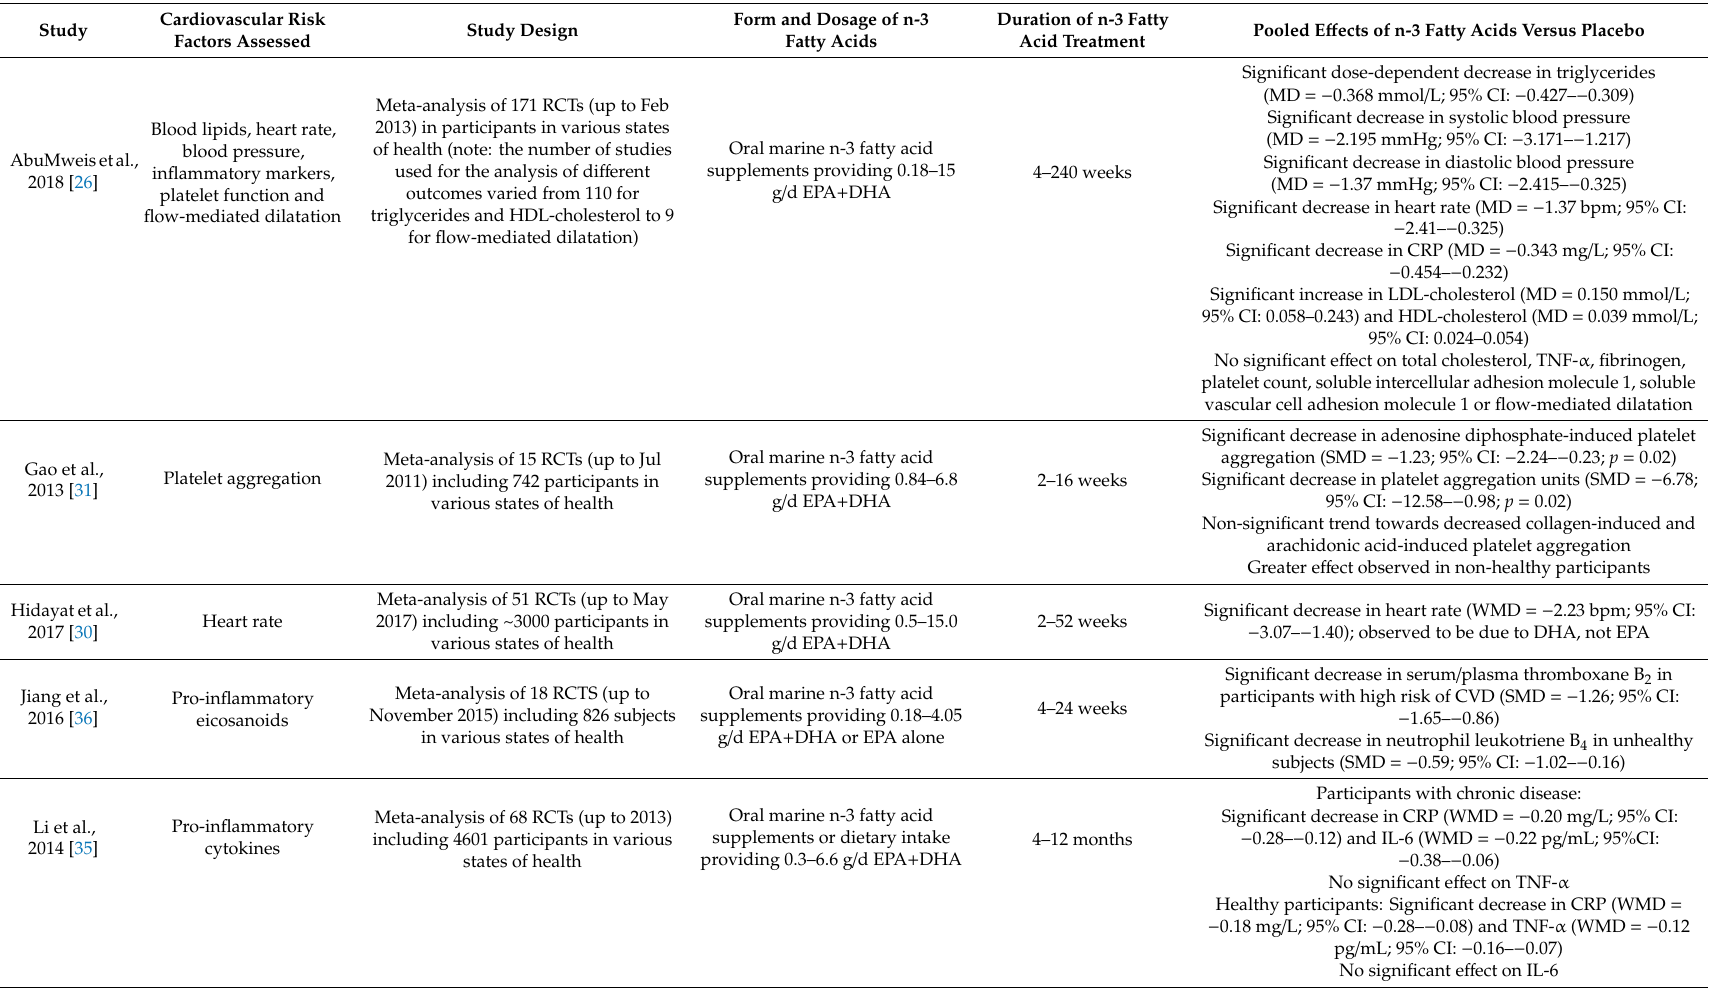
Table 2. Selected meta-analyses of the e ff ect of marine n-3 fatty acids on cardiovascular risk